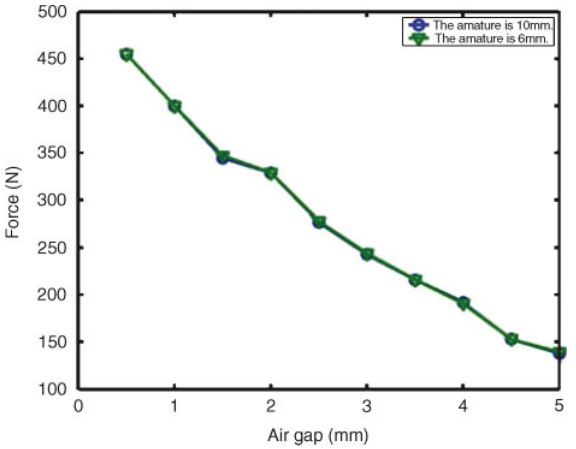
Figure 10 Influence of thickness of the armature.